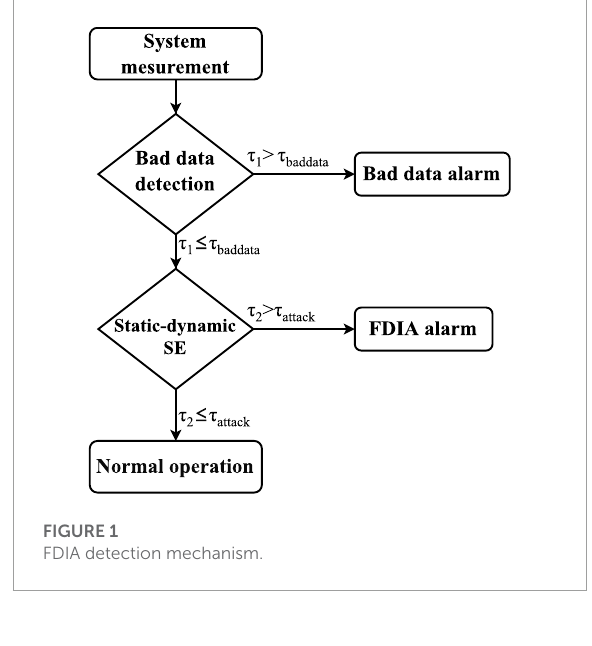
FIGURE 1 FDIA detection